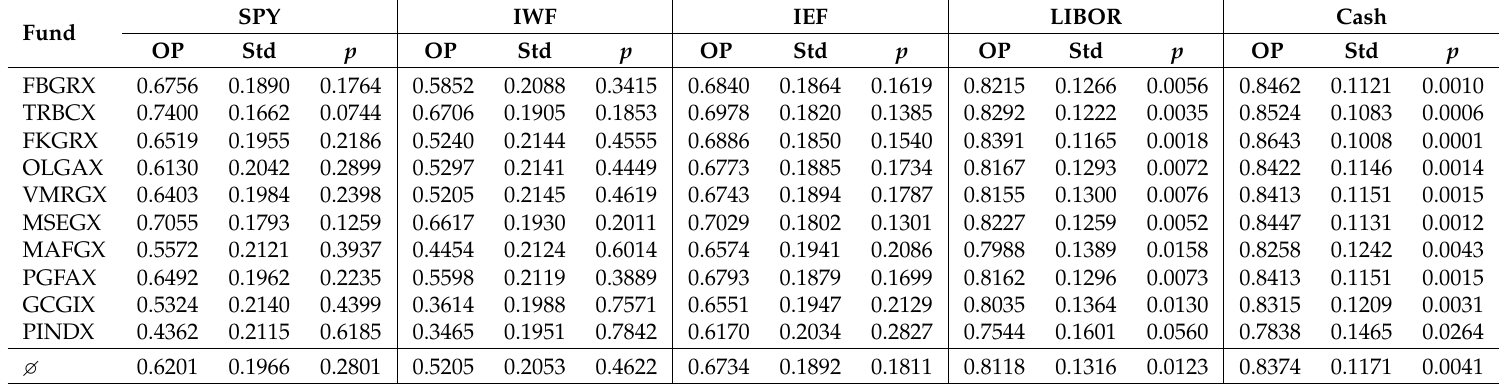
Table 8. Results in the case that T is Weibull distributed with κ = 2 and γ =